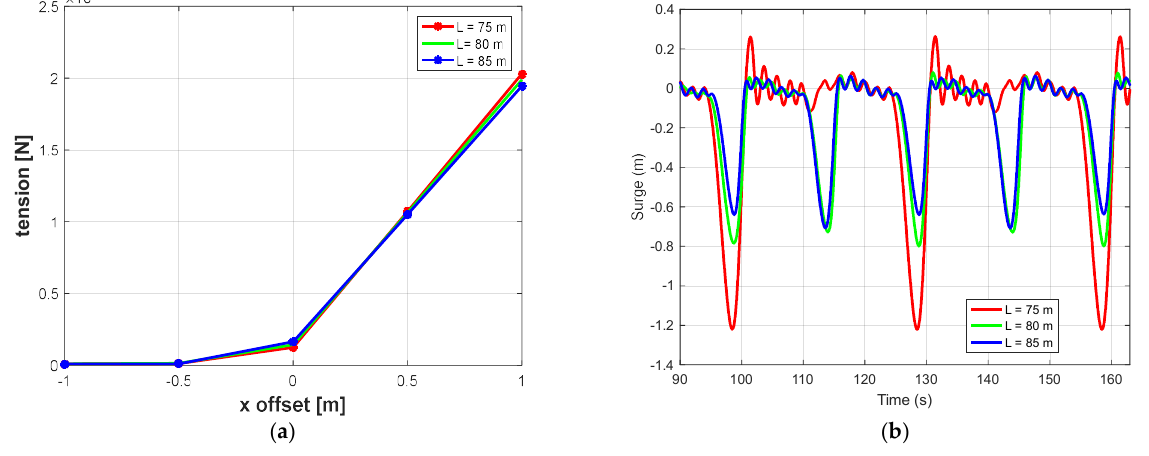
Figure 7. In-plane motions with variations in mooring length. ( a ) stiffness curve, ( b ) surge time series.